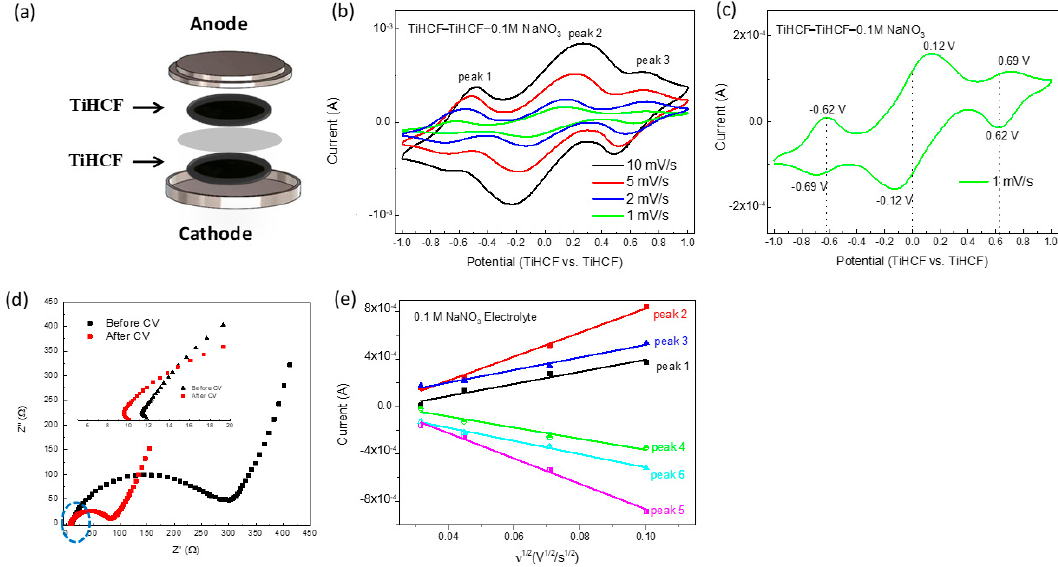
Figure 2. Electrochemical performances of the full cell using TiHCF pellet as both cathode and anode material at the potential range − 1.0~1 V: ( a ) schematic diagram of TiHCF full cell; ( b ) CV curves at different scan rate; ( c ) CV curve at 1 mV/s; ( d ) EIS analysis of the full cell before and after CV test; ( e ) relationship between the peak currents ( I p ) and the square root of the scan rate ( v 1/2 ).